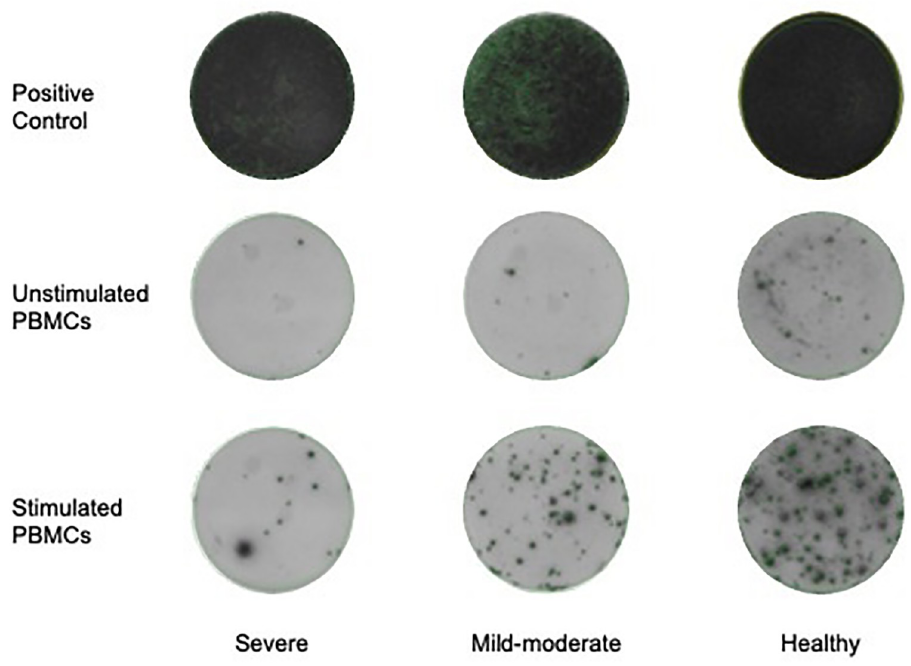
Fig 2. The figure reports a representative IFN- γ ELISPOT from one case per severe, mild-moderate and healthy cohorts, from the left to the right.